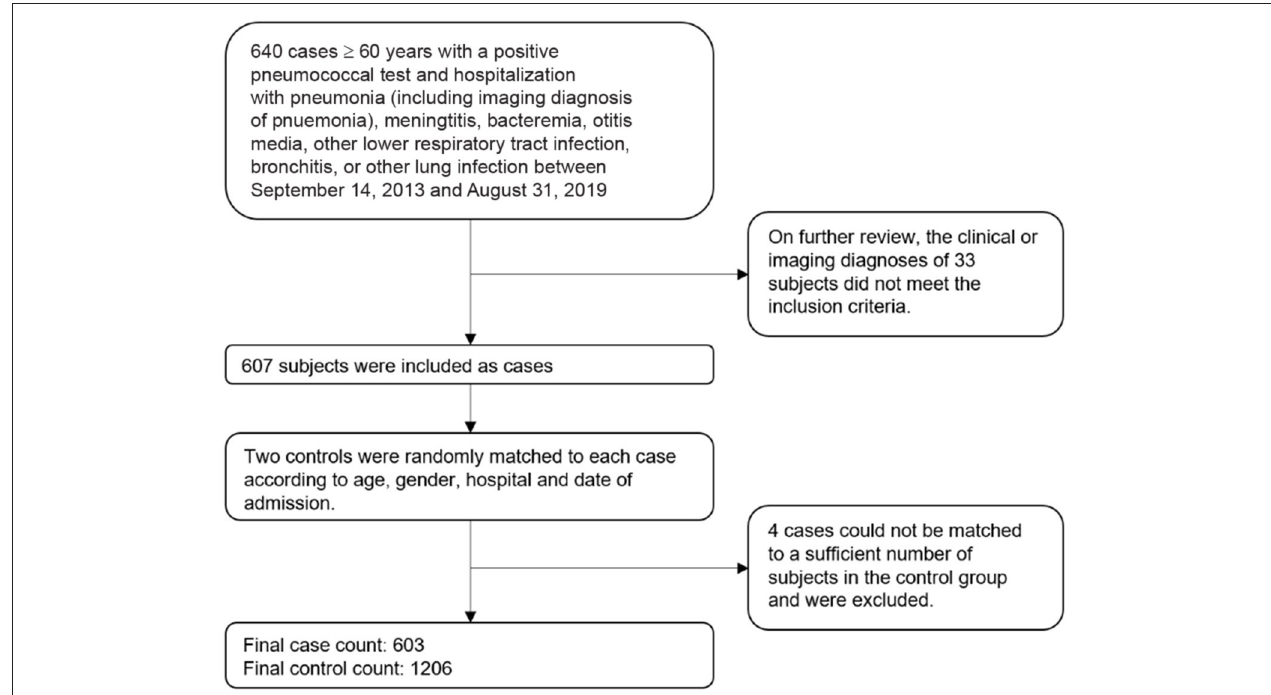
FIGURE 1 | Sampling schematic of cases and controls in the study of pneumococcal vaccine effectiveness in Shanghai.